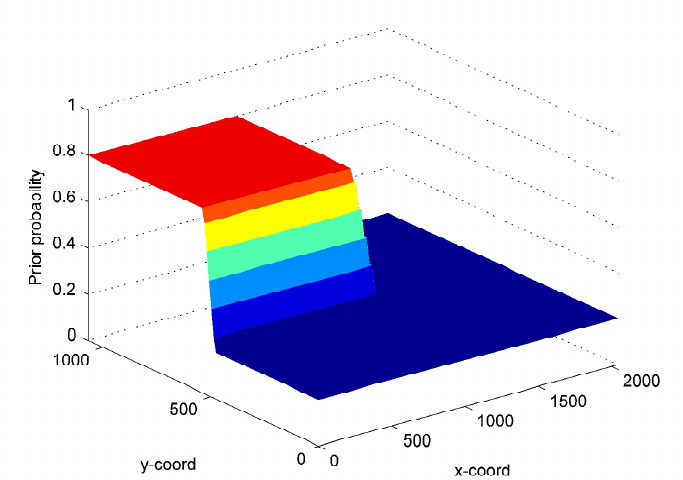
Figure 8. Non-uniform prior probability p ( x ) considered in the example depicted in Figure 9(b). x - and y - coordinates in millimeters.